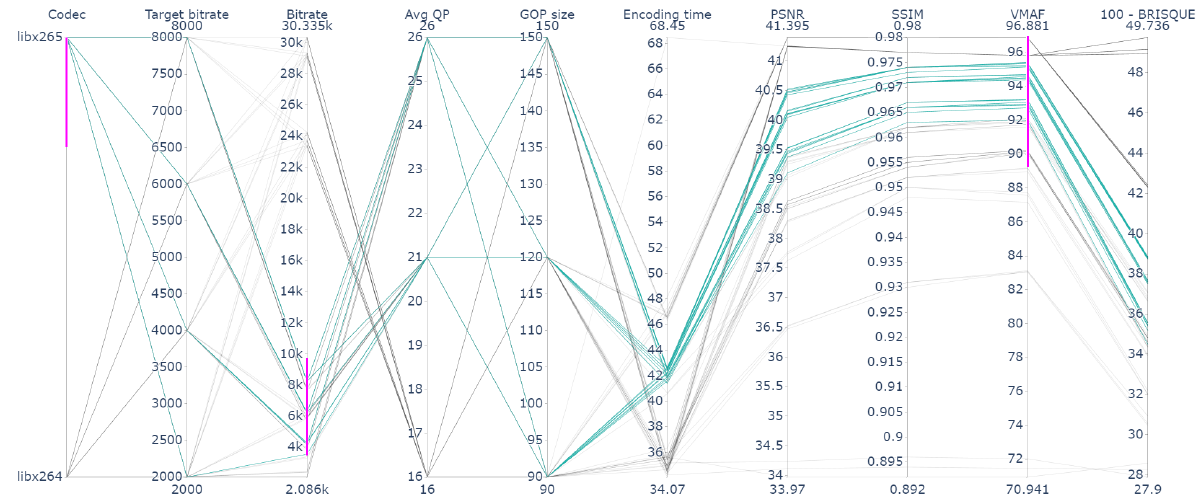
Figure 9. x265 filtered purple color parallel coordinates (filtered with magenta